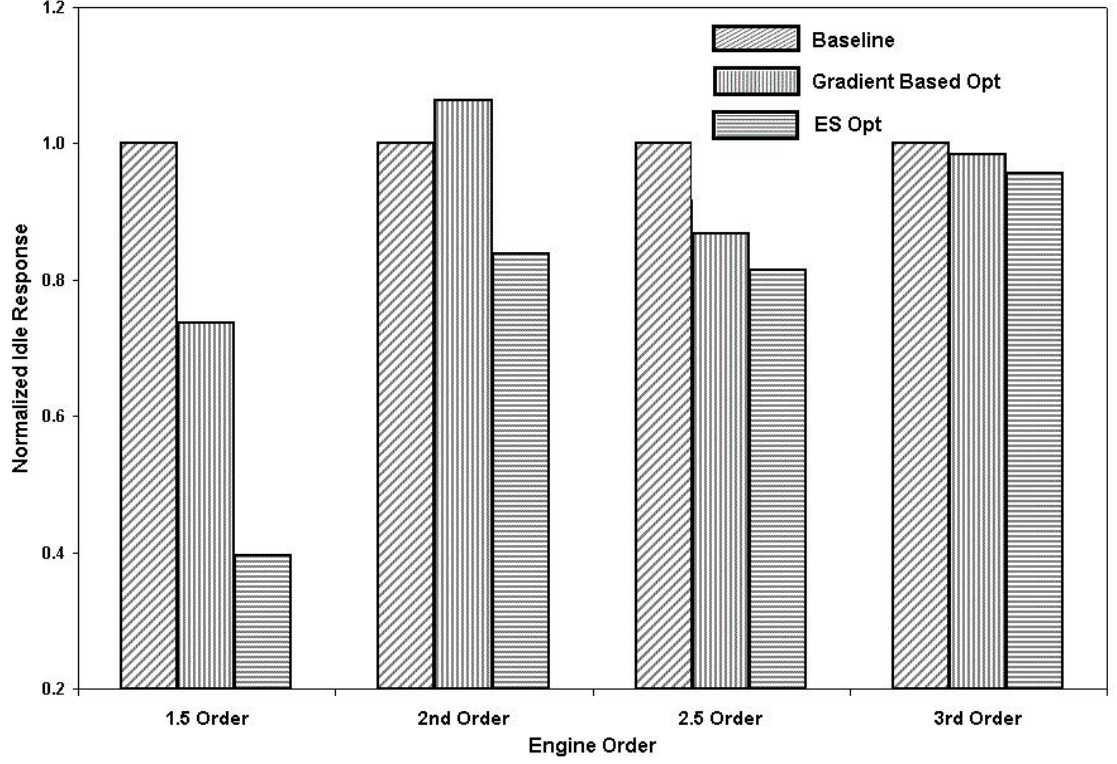
Fig. 11. Idle shake response at the steering column in the full-vehicle system for different engine